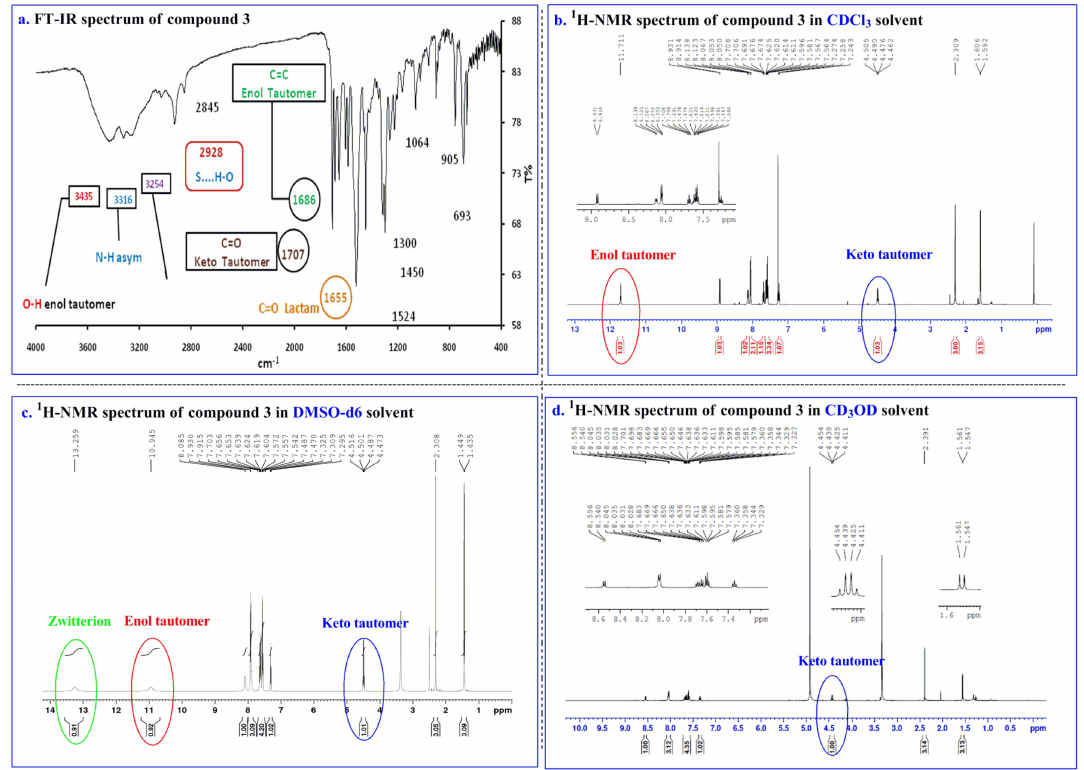
Figure1. ( a )FTIRspectrumofCompound 3 . ( b – d ) 1 H-NMRspectraofCompound 3 indi ff